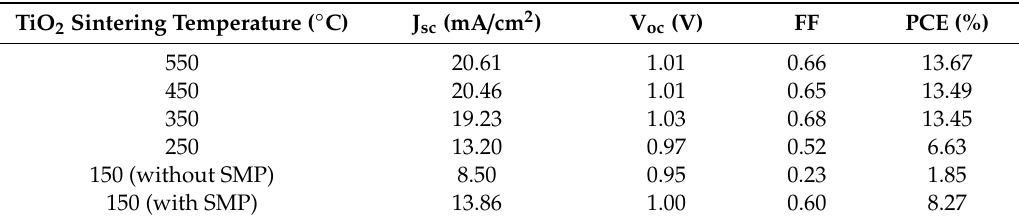
Table 1. Photovoltaic parameters (current density (J sc ), open-circuit voltage (V oc ), fill factor (FF), and power conversion e ffi ciency (PCE)) for perovskite solar cells based on mesoporous TiO 2 sintered at di ff erent temperatures, with and without the surface modification process (SMP).